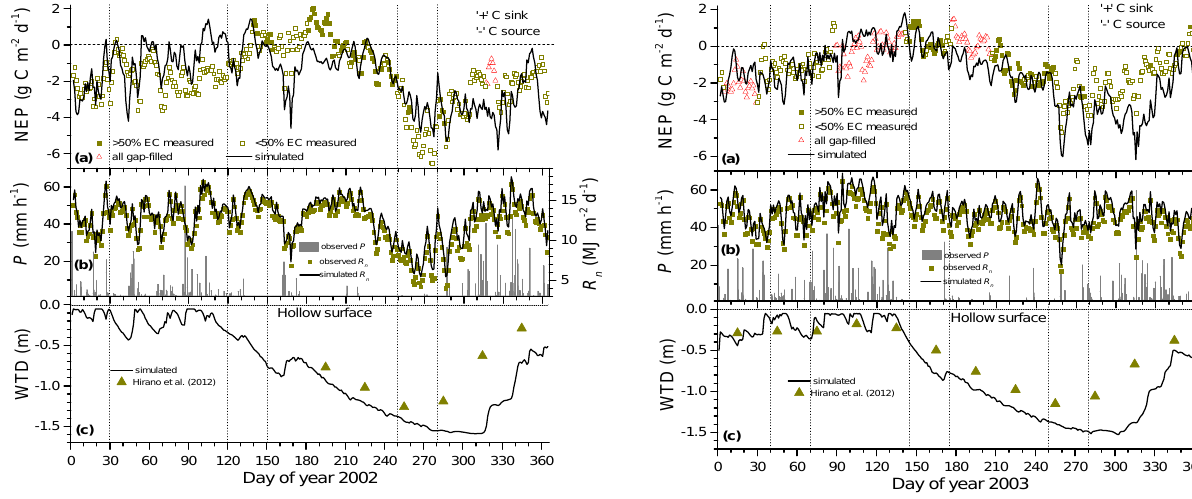
Fig. 3. (a) Three day moving averages of simulated and EC-gap filled estimates of net ecosystem productivity (NEP). Solid squares indicate sums of 24 values more than 1/2 of which were recorded at u ∗ (friction velocity) >0.17ms − 1 , open squares indicate sums of 24 values more than 1/2 of which were gap-filled, and open triangles indicate sums of 24 values all of which were gap-filled; (b) hourly measured precipitation ( P) and three day moving averages of sim- ulated and measured net radiation ( R n ) ; and (c) monthly measured (values digitally obtained from Hirano et al., 2012) and daily mod- elled water table depths (WTD) from hollow surface during 2003 over a drainage affected tropical peat swamp forest at Palangkaraya, Indonesia. Negative values of WTD mean depths below the